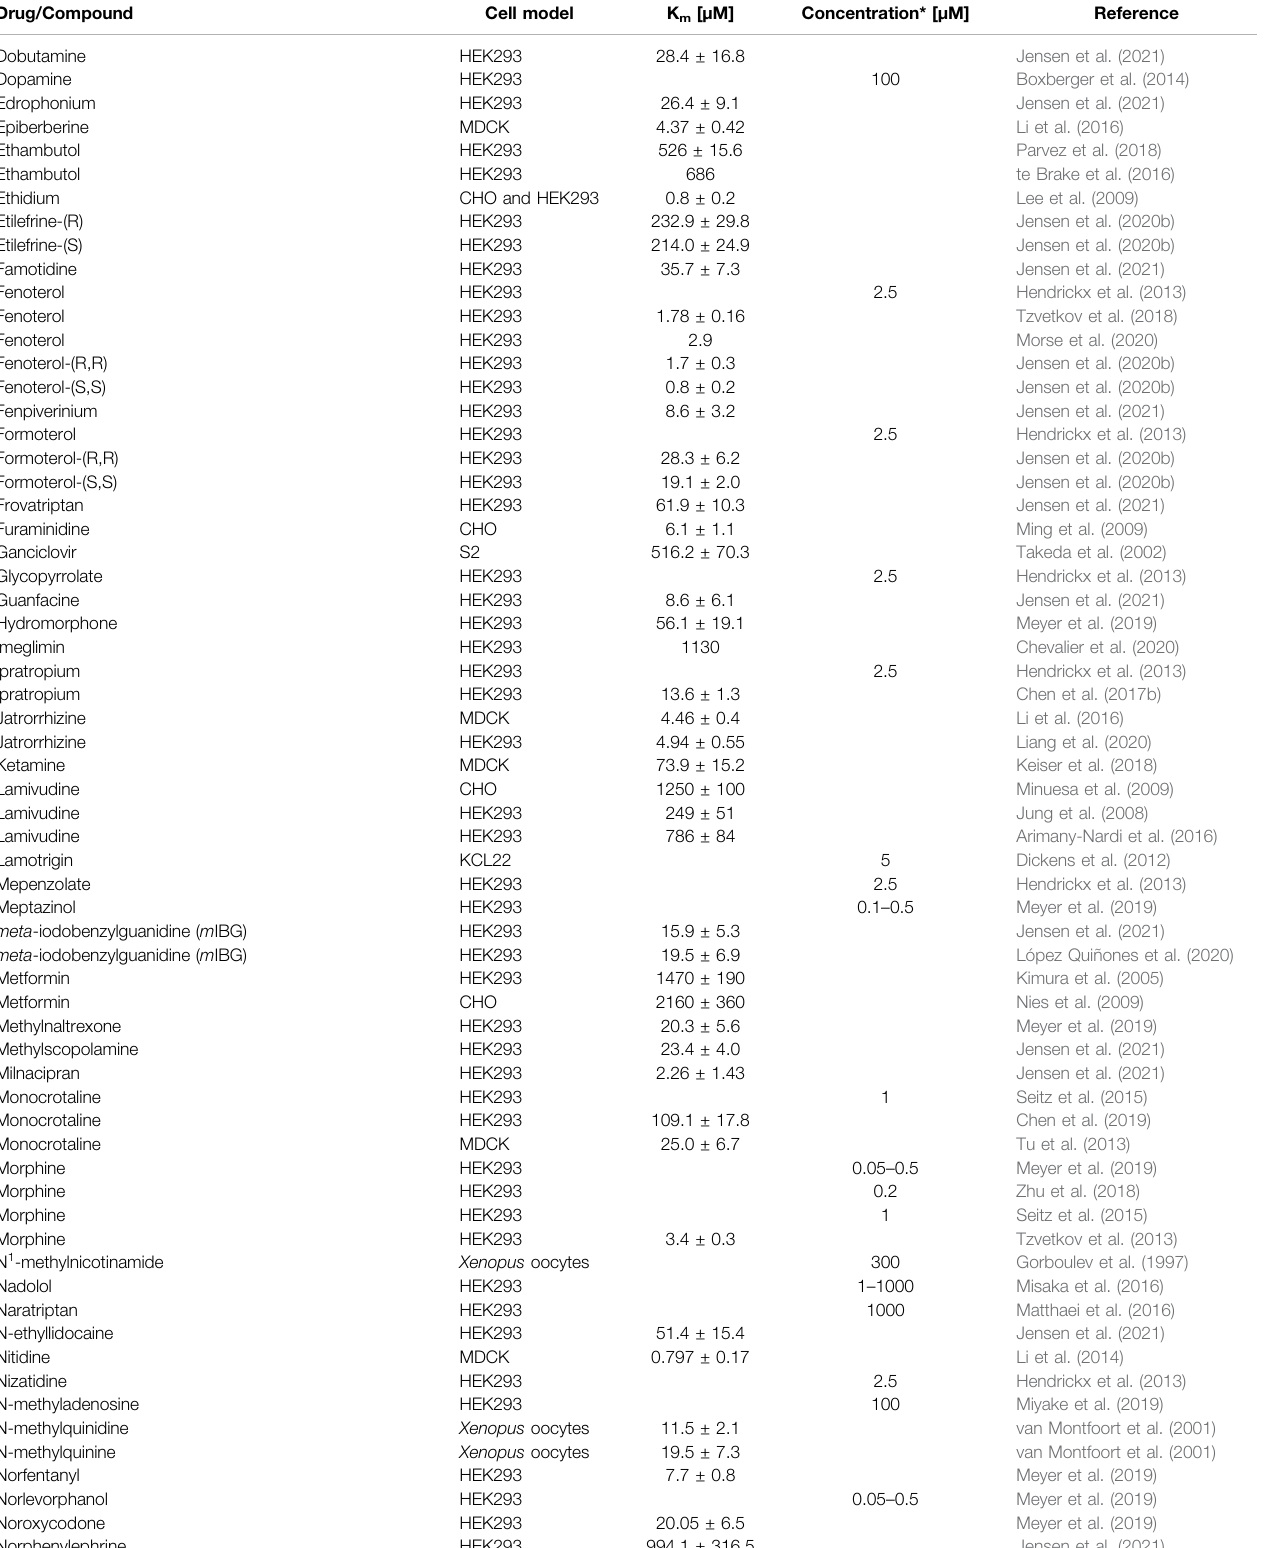
TABLE 1 | ( Continued ) Substrates of OCT1 (drugs, drug metabolites, endogenous molecules, chemicals) studied in single-transfected cell